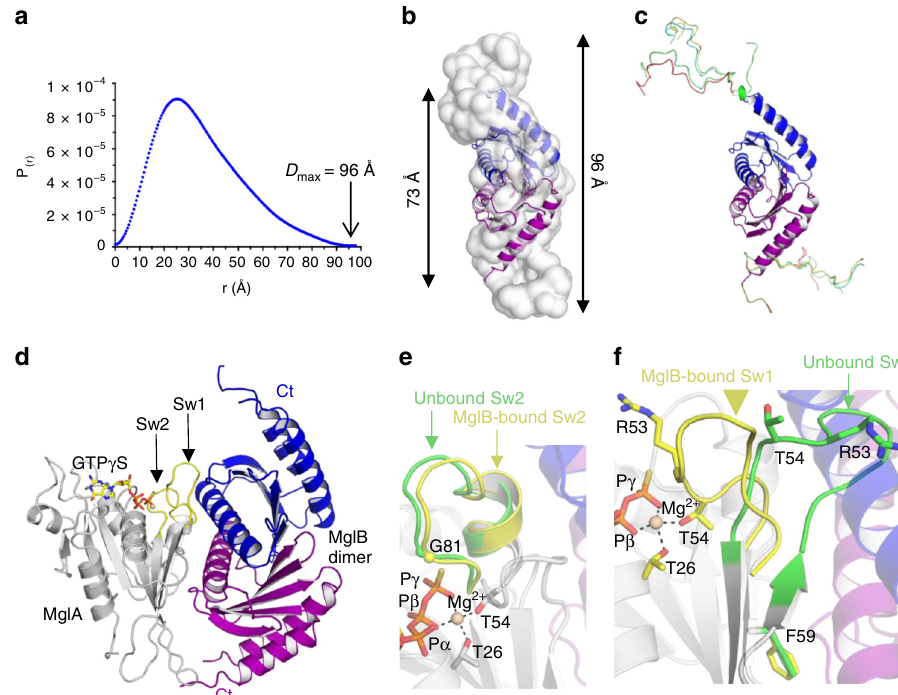
Fig. 2 Crystallographic and solution structural analysis of MglB. a SEC-SAXS distance distribution function P ( r ) of unbound MglB in solution. The D max value is indicated. Complementary information on SAXS data collection and analysis is given in Supplementary Fig. 2f – i. b Comparison of the crystallographic MglB dimer (in blue and purple) with the SAXS envelope calculated with GASBOR. The C-terminii are not visible in the crystal structure, but appear as extra volumes in the SAXS envelope (arrows). The D max values calculated from the crystal structure and the SAXS data are indicated. c A composite model of the MglB dimer, in which the C-terminii is represented by ensemble structures calculated with MultiFoXS. d Crystallographic structure of the MglA- GTP γ S/MglB heterotrimer. MglB interacts with switch 1 and with nonswitch regions of MglA, forming an interface that is asymmetrical on the MglA side and symmetrical on the MglB dimer side. The position of the C-terminii of MglB is not visible in the crystal. e Close-up view of the overlay of switch 2 in unbound (green) and MglB-bound (yellow) MglA-GTP γ S, showing that the conformation of switch 2 is not remodeled by MglB. f Close-up view of the overlay of switch 1 in unbound (green) and MglB-bound (yellow) MglA-GTP γ S, showing that MglB induces a lasso movement of the arginine fi nger loop that resolves steric con fl icts and brings Arg53 and Thr54 into the nucleotide-binding